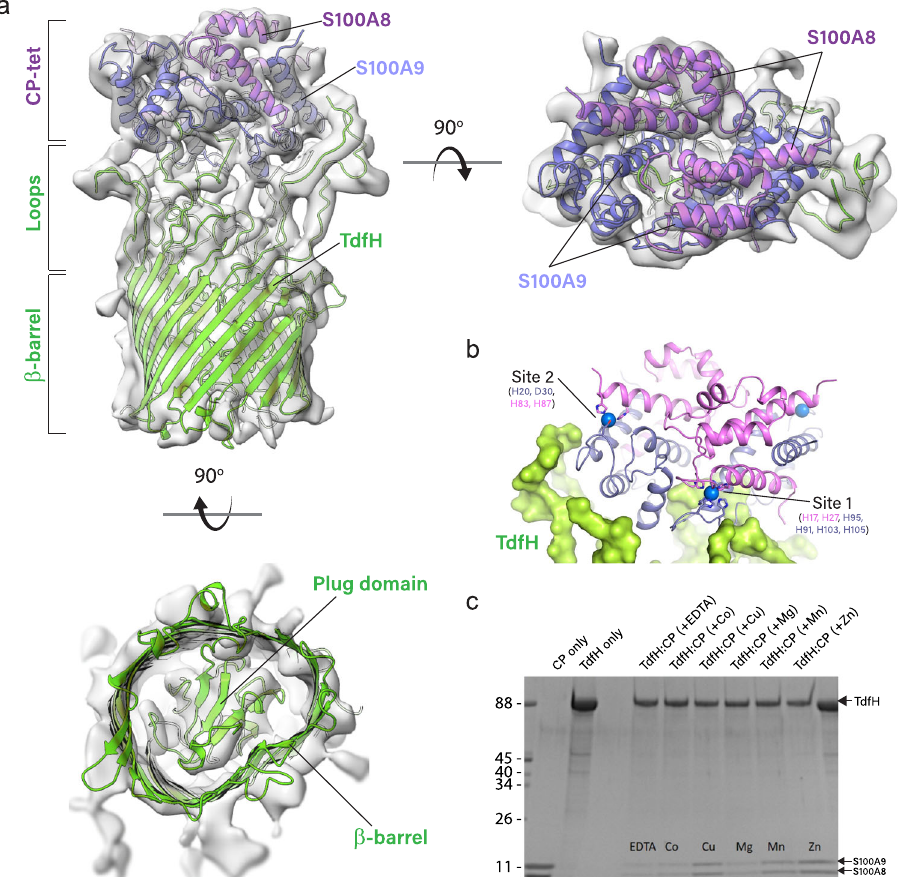
Fig. 2 CryoEM structure of the TdfH-CP complex to 6.1 Å resolution. a Orthogonal views of the cryoEM map aligned with the TdfH-CP complex structure (TdfH is in green, S100A8 in violet, and S100A9 in lavender). For clarity, calcium and zinc are not shown and the “ surface dust ” option in ChimeraX was used which removed most of the micelle density. b Zoomed view of the interaction of TdfH with site 1 and site 2 of CP, with zinc shown as blue spheres. For clarity, this view is rotated ~180° compared to the view in panel a and calcium is not shown. c Pull-down assays demonstrate that TdfH is able to bind